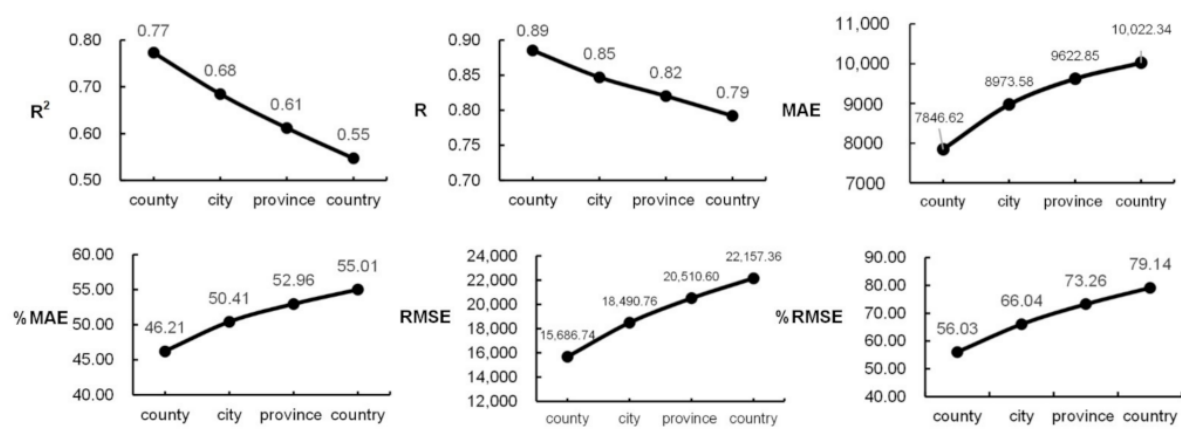
Figure 13. Variation in the accuracy of gridded population data based on county-scale, city-scale, province-scale, and country-scale census data in terms of 6 accuracy